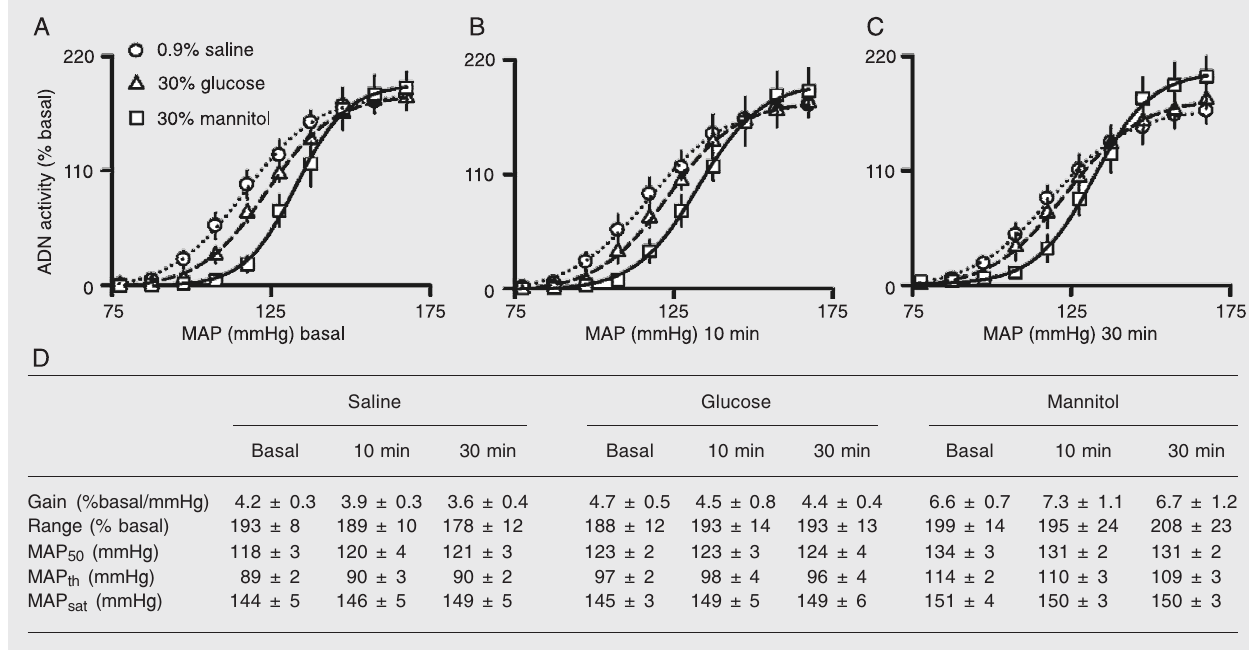
Figure 2. The plots show mean arterial pressure (MAP) vs aortic depressor nerve (ADN) activity curves (top), expressed as percentage of basal activity using 4-parameter logistic sigmoidal regression, obtained before (basal, A), 10 min (B), and 30 min (C) after the beginning of intravenous infusion of 30% glucose, 0.9% saline, or 30% mannitol. D , Data used to construct the curves. MAP 50 = MAP corresponding to 50% of ADN activity range; MAP th = threshold MAP for baroreceptor activation; MAP sat = MAP for saturation of discharges. Data are reported as means ± SEM for 7 rats in each group.